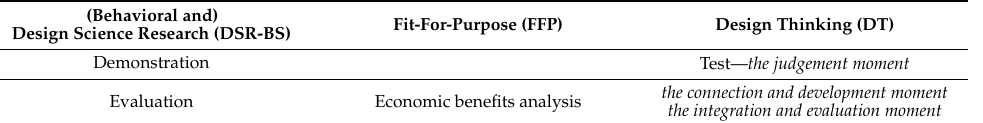
Table 9. Extract of the piloting/demonstration and evaluation